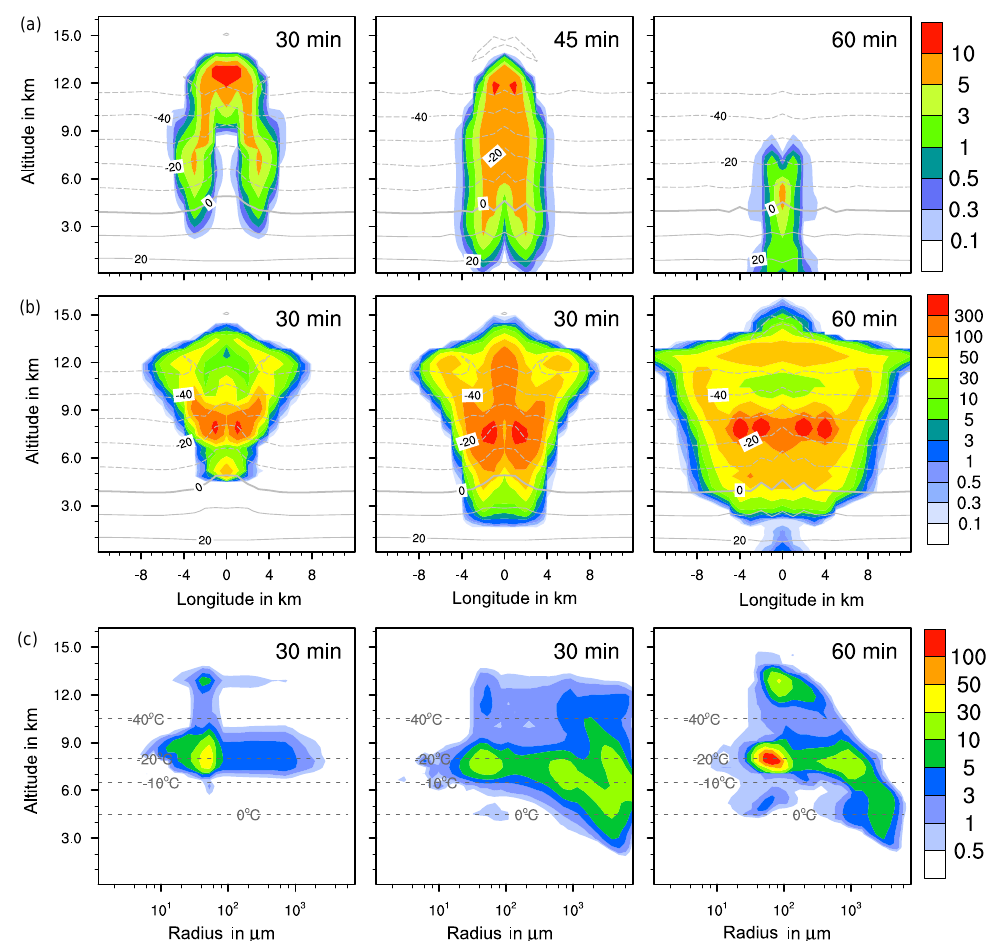
Figure 6. Ice formation from contact freezing with 10% feldspar. (a, b) Temporal development of two parameters shown in a vertical cut through the cloud center. Horizontal dashed lines: temperature in ◦ C. (a) Ice water contents in gkg − 1 and (b) ice particle numbers per m 3 . (c) Ice particle size spectra in the center cell of the cloud at different times. Number concentrations per m 3 . Left pictures in (b) and (c) show primary contact freezing